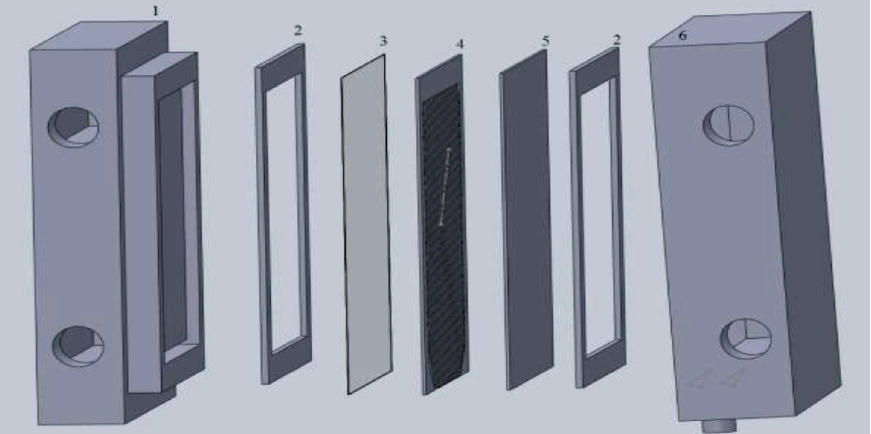
Figure 3. Exploded view of the AGMD module assembly: (1) hot compartment, (2) rubber gaskets, (3) membrane, (4) spacer, (5) condensation plate and (6) cold compartment.